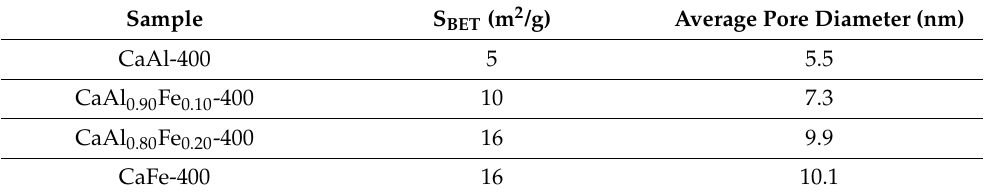
Table 2. S BET and average pore diameter of samples calcined at 400 ◦ C.